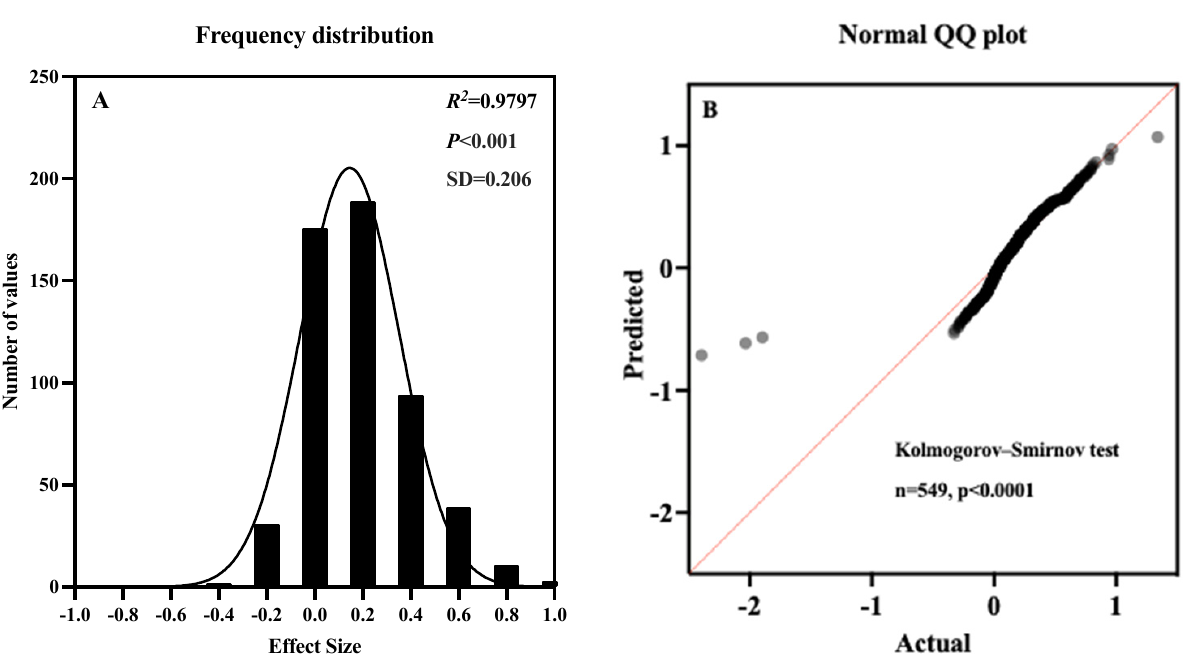
Figure A1. Frequency distribution ( A ) and QQ plot ( B ) of effect size of melatonin on plant growth under salt stress.